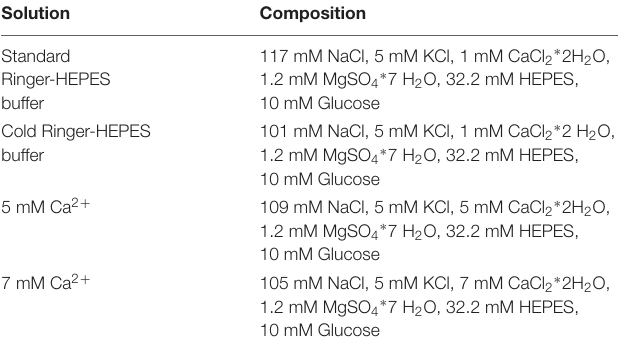
TABLE 1 | Perfusion solutions.